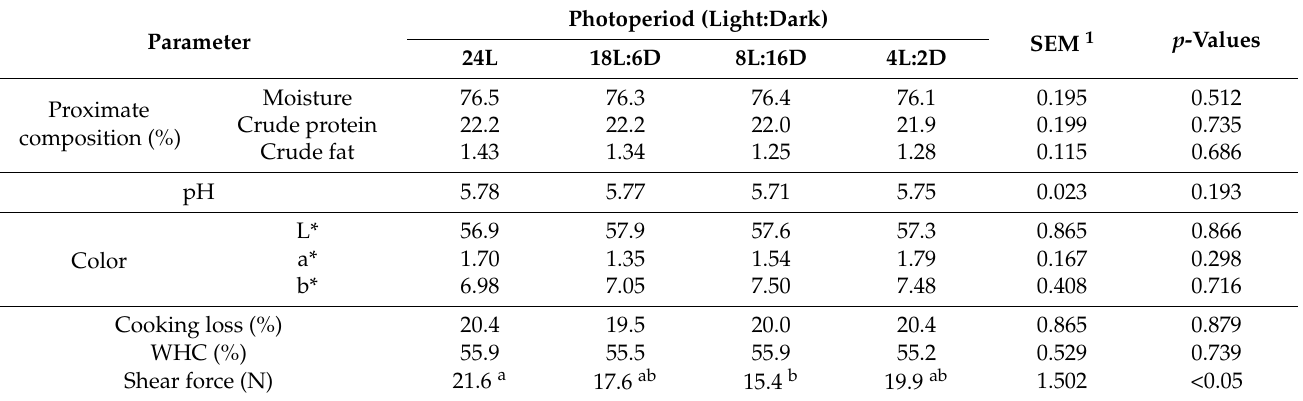
Table 8. Effect of photoperiod on physicochemical characteristics of breast meat of broilers. Photoperiod Parameter